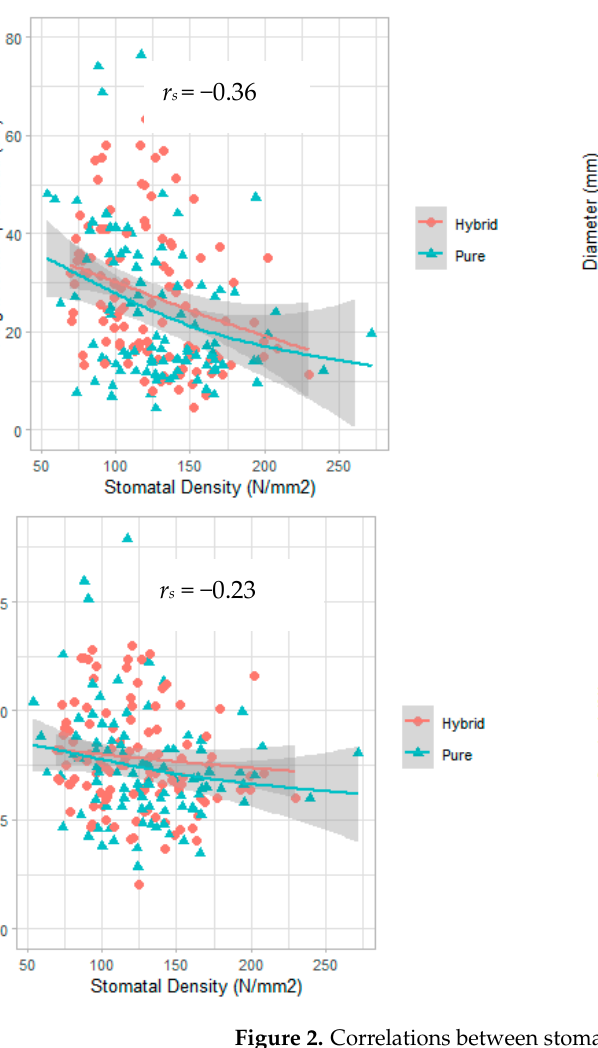
Figure 2. Correlations between stomatal density (N/mm 2 ) and basal diameter (mm), height to apical bud (cm), maximum height to the top of the needles (cm) per individual, and survival by seed stand in individuals of the three selected pure species ( Pinus durangensis , P. engelmannii, and P. teocote ) and their hybrids ( P. durangensis × P. arizonica , P. durangensis × P. engelmannii , P . engelmannii × P. arizonica , and P. tecote × P. leiophylla ). Mean values (cyan and red lines) and the 95% confidence level intervals for predictions (grey area) are based on generalized additive models (GAM). Table 7. Spearman’s correlation ( r s ) (and p -value) between the stomatal density and the basal diameter, height to the apical bud, and maximum height to the top of the needles per seedling. In addition, Spearman’s correlations ( r s ) (and p -value) between the stomatal density and survival in seedlings of the three selected pure pine species ( Pinus durangensis , P . engelmannii, and P. teocote ) and their hybrids ( P. durangensis × P. arizonica , P. durangensis × P. engelmannii , P. engelmannii × P. arizonica , and P. teocote × P . leiophylla ) ( α = 0.025) are shown for each trial. Variable r s p -Value